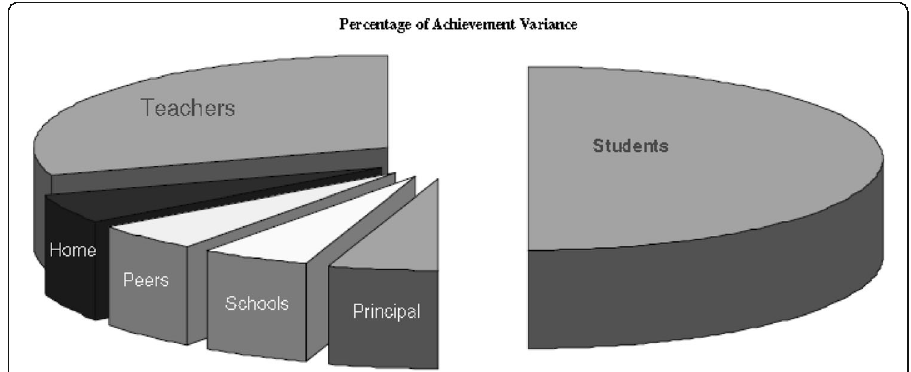
Fig. 1 Percentage of achievement variance